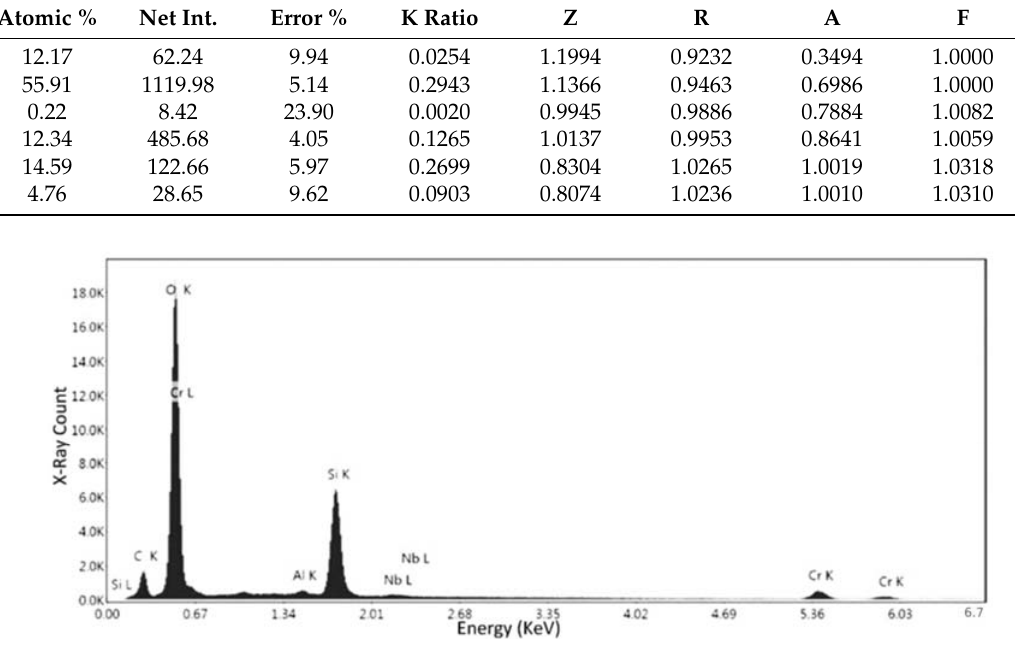
Figure 14. EDS measurement of the second point for specimen No. 5.